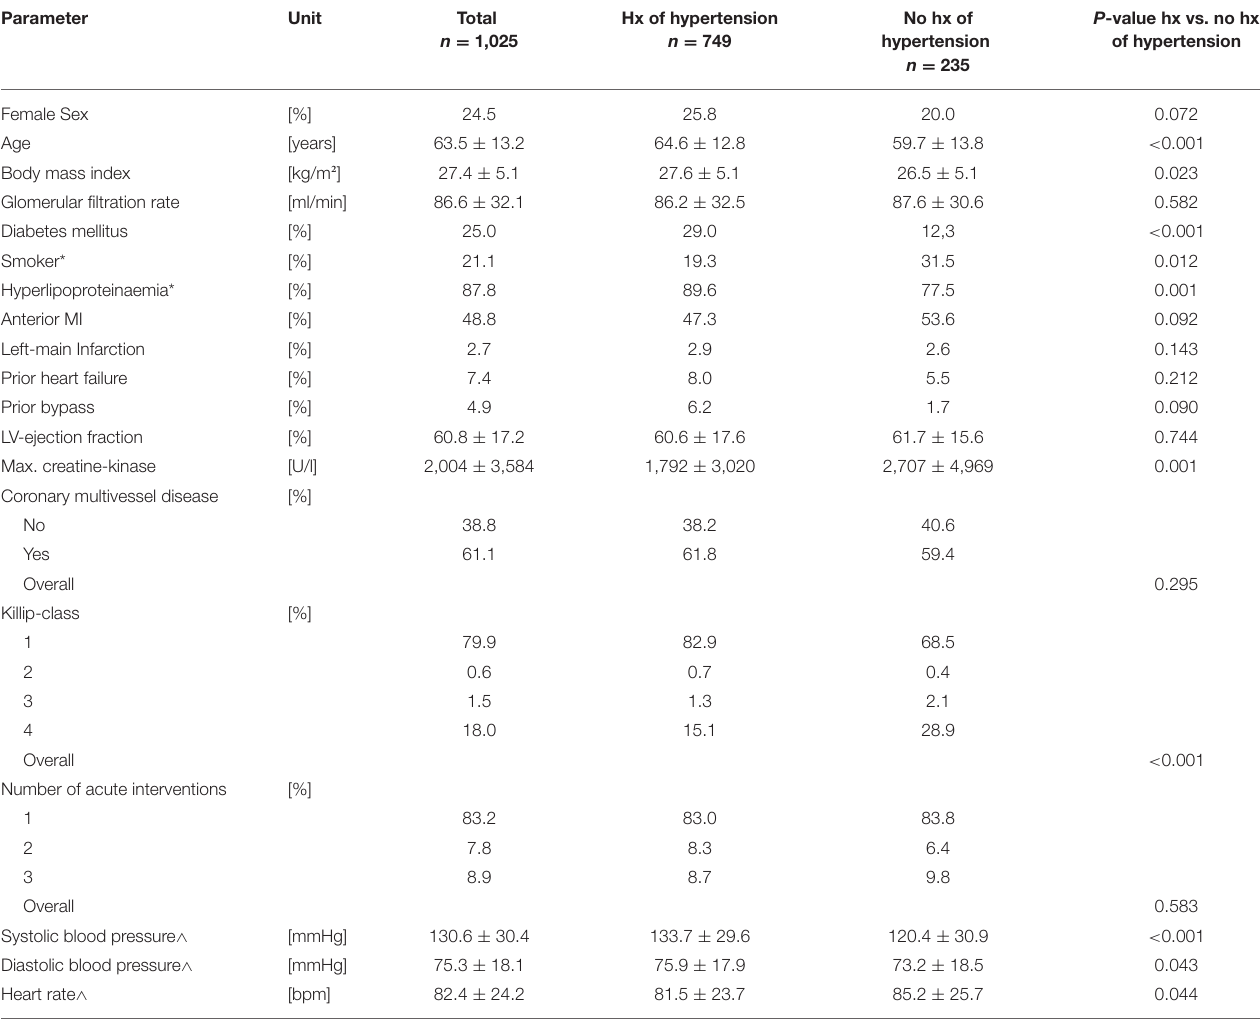
TABLE 1 | Baseline